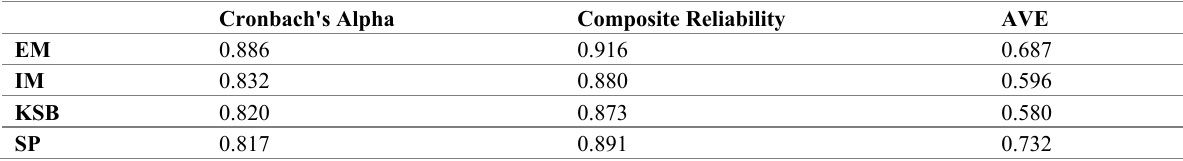
Table 4: Reliability and Validity Construct